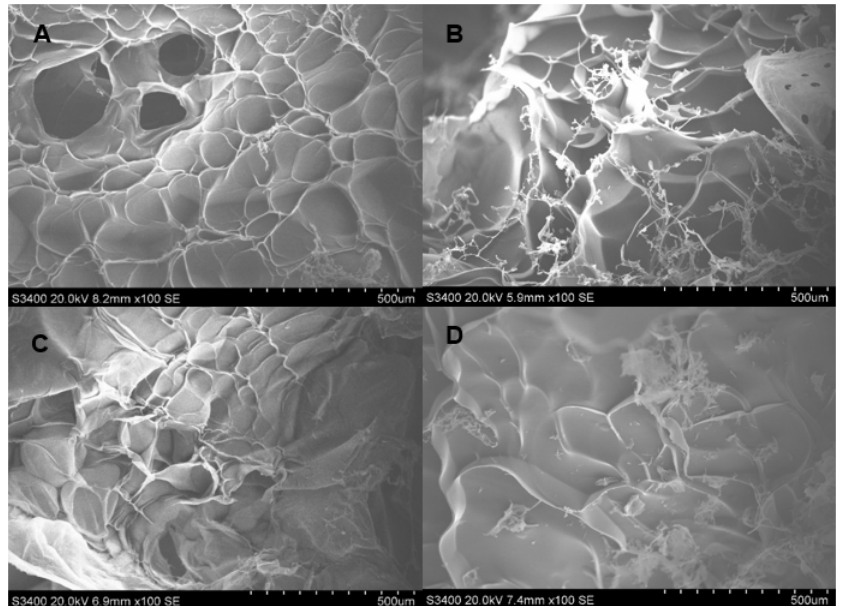
Figure 1. SEM images of hydrogel porous scaffolds made from solution of ( A ) 3% w / w gelatin (100 × ); ( B ) 3% w / w gelatin and 2% glutaraldehyde (100 × ); ( C ) 3% w / w gelatin and DOX (100 × ) and ( D ) 3% w / w gelatin, DOX, and 2% glutaraldehyde (100 × ).